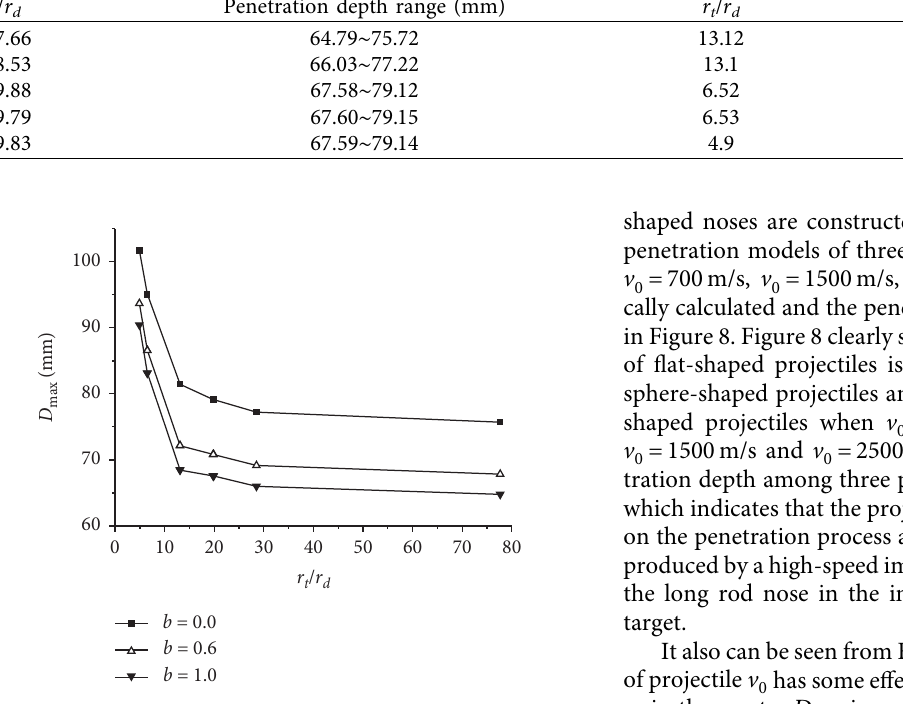
Figure 6: Comparison of penetration depth.